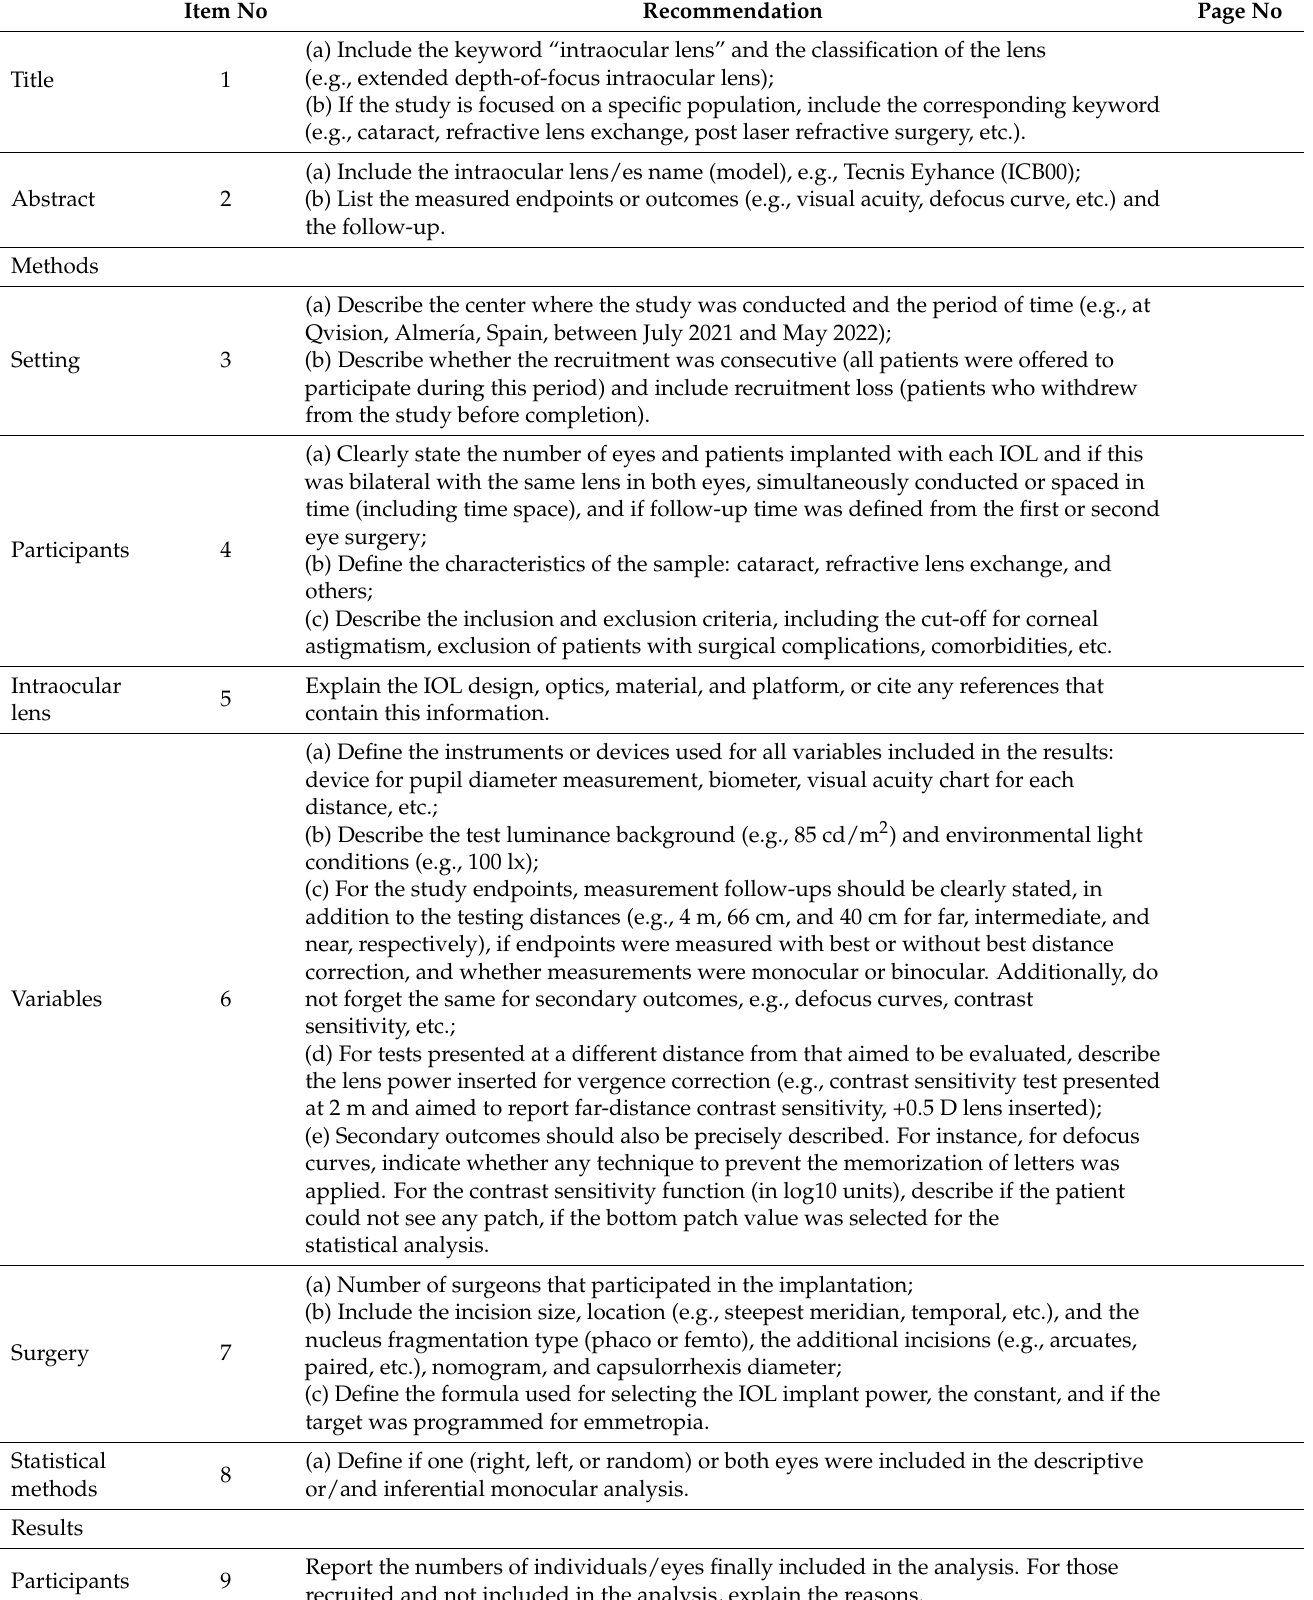
Table 1. Checklist of items recommended to be included in reports of IOLs. (v1.0; December 2022). Item